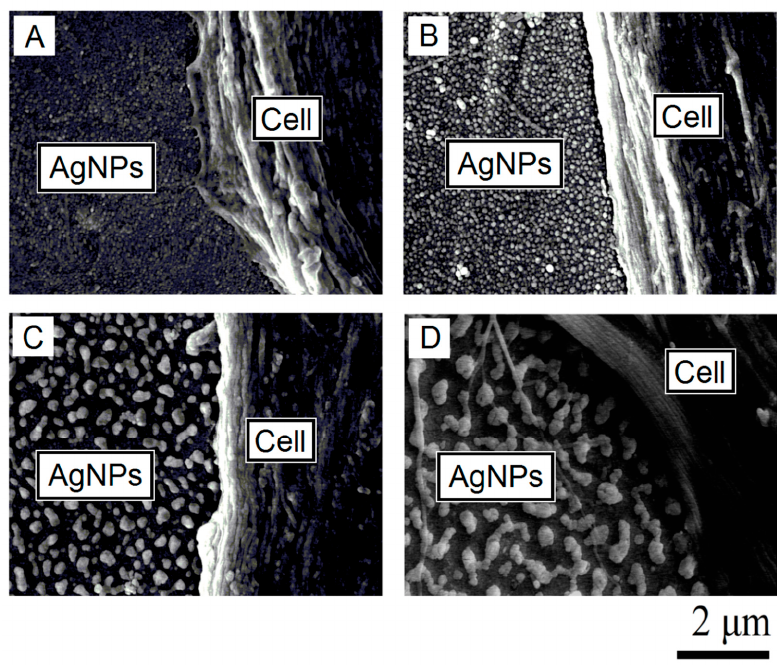
Figure 7. SEM images with nanoparticles of appropriate average diameter ( A ): 60 nm; ( B ): 96 nm; ( C ): 149 nm; ( D ): 368 nm and cell growth on them.